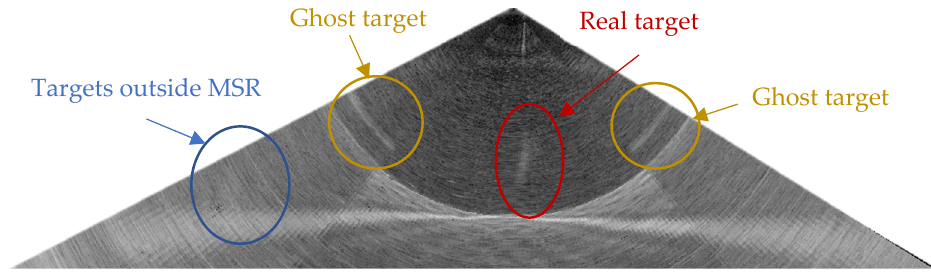
Figure 18. Different types of targets in the water column images.